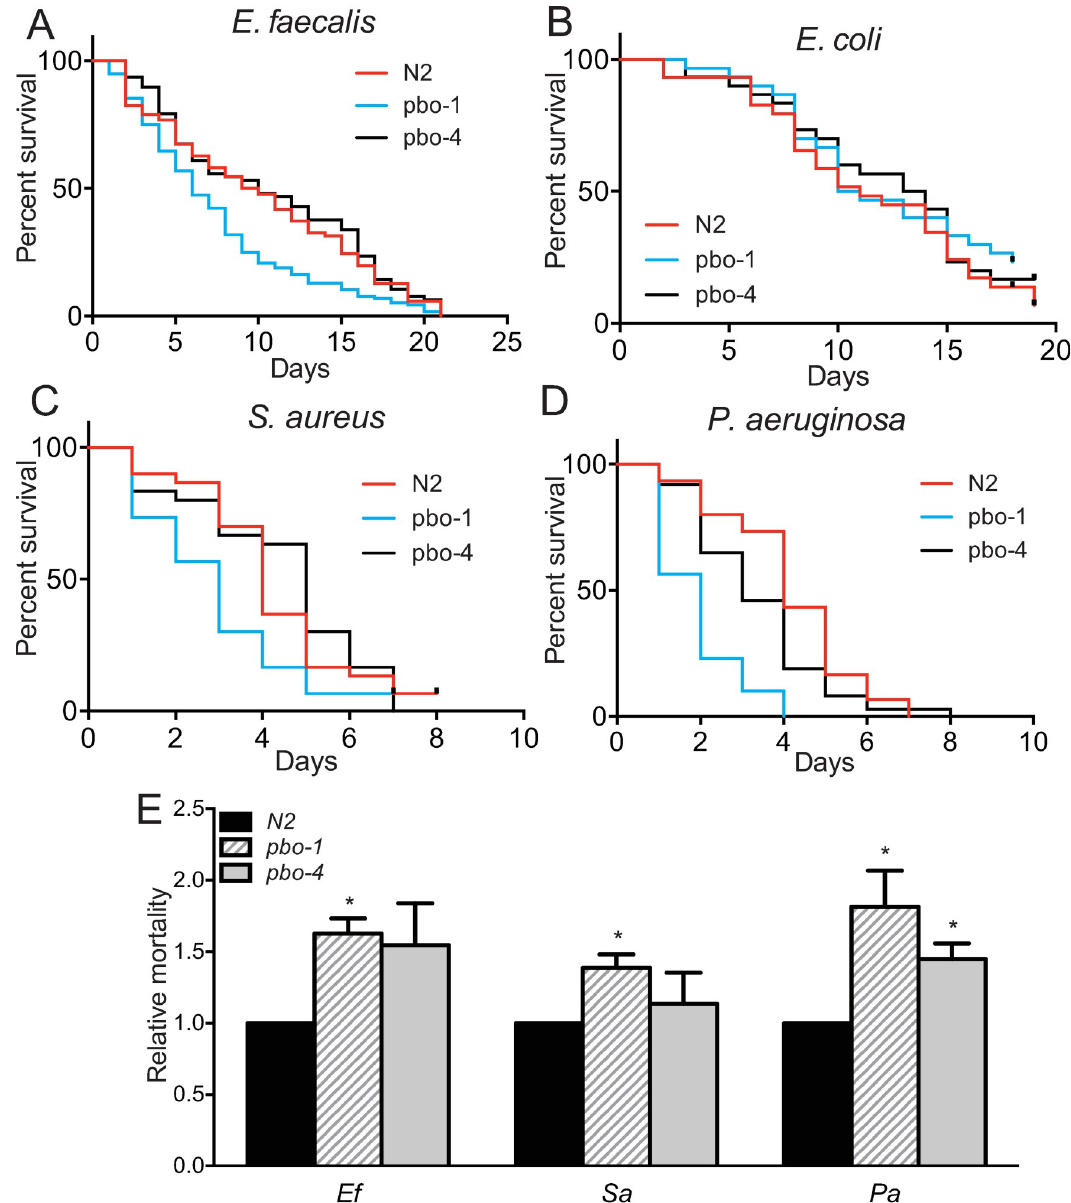
Fig 2. pbo-1 loss-of-function increases susceptibility to bacterial pathogens. (A-D) Survival or longevity of C . elegans wild type versus pbo-1 , or pbo-4 mutants placed on nematode growth medium (NGM) with a lawn of E . faecalis (A), E . coli (B), S . aureus (C), or P . aeruginosa (D). In each experiment, 30–100 worms were placed on the pathogen lawn and subsequently transferred every two days to a new NGM plate with a fresh pathogen lawn and monitored for survival. (E) Average relative mortality on pathogen ( E . faecalis , P . aeruginosa or S . aureus ). Relative mortality is calculated using the lethal time to kill 50% of organisms (LT 50 ) and is the ratio of (wild-type LT 50 /mutant LT 50 on pathogen) over (wild-type LT 50 /mutant LT 50 on E . coli ). LT 50 and p values for individual experiments used for relative mortality calculations are provided in S1 Table. Relative mortality is shown as the average and standard error of the mean of 3–4 experiments. For each pathogen, statistical analysis by student’s t test compared with wild type: � , p < 0.05. 50% of wild-type animals fed E . faecalis on nematode growth media (NGM) were killed with a median survival (LT ) of 9.5 ± 1 days, post infection (Fig 2A). By contrast, 50% of pbo-1 50 mutants were killed after an average of 6 ± 1 days of E . faecalis feeding, which was significantly